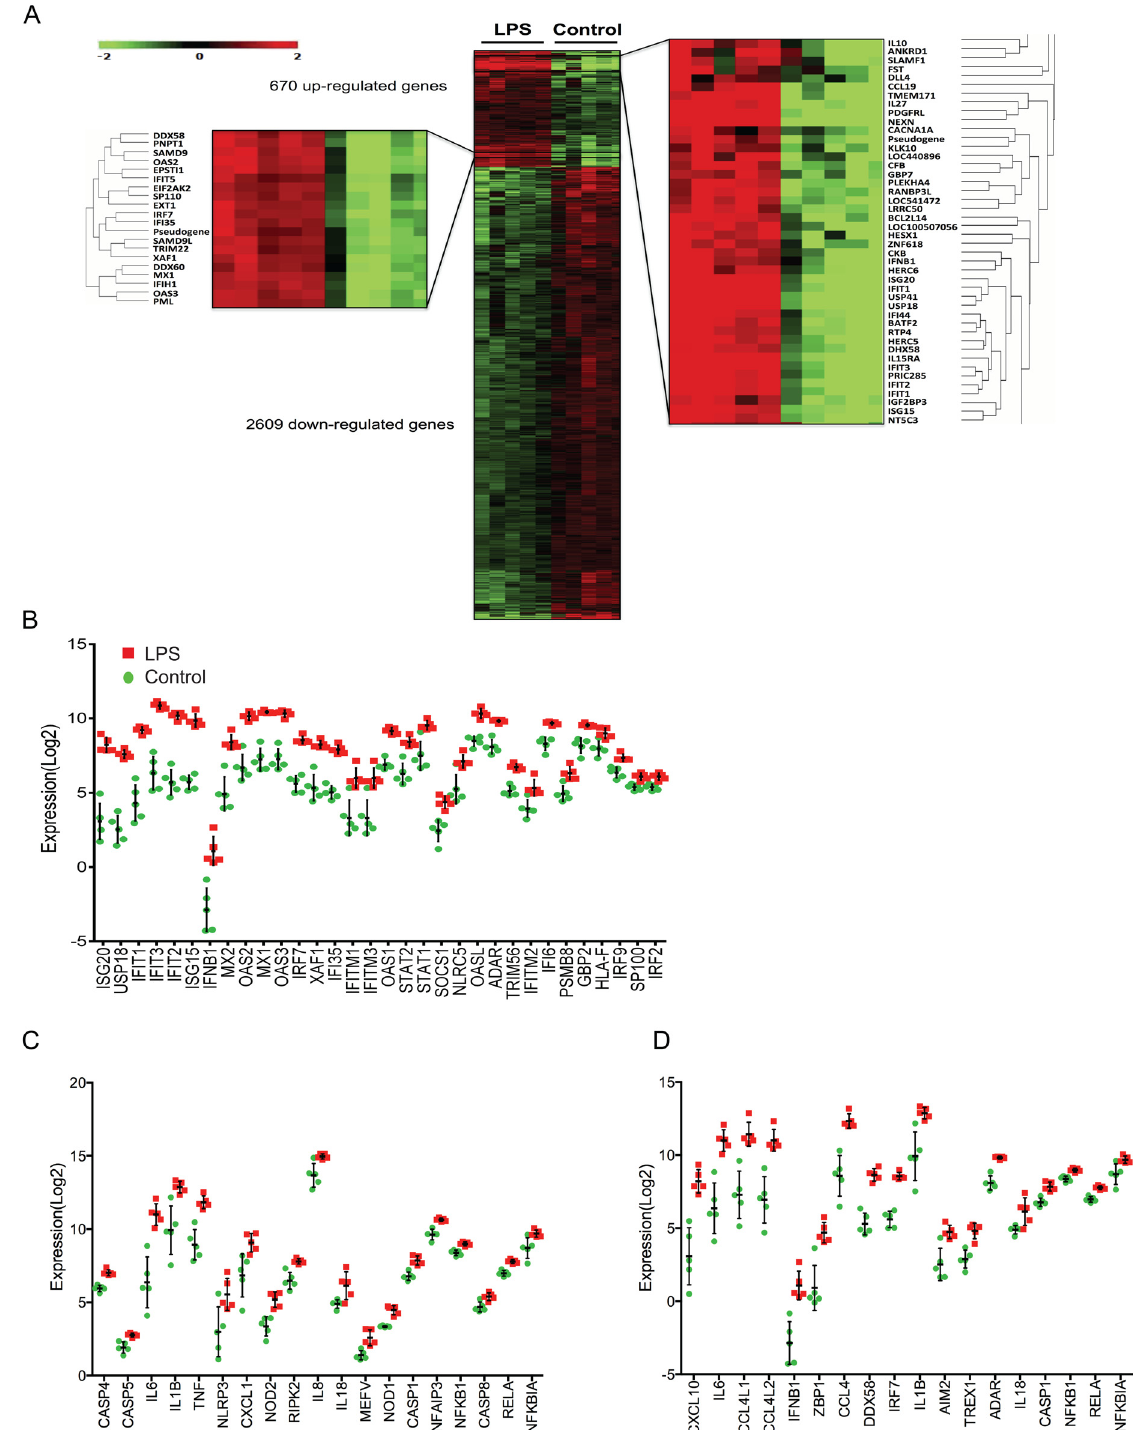
Fig 2. Heat Maps of differentially regulated genes and individually regulated genes within select gene pathways. RNA-Seq was performed in human alveolar macrophages from healthy volunteers to assess transcriptomic changes following ultrapure LPS stimulation in vitro (n = 5). (A) Of 3279 genes that were differentially expressed, 670 were upregulated and 2609 were downregulated and depicted in the heat map. Each column in the heat map represents a study subject and each row represents a gene. The order in the heat map was obtained in unbiased fashion by hierarchical clustering centered around genes with average